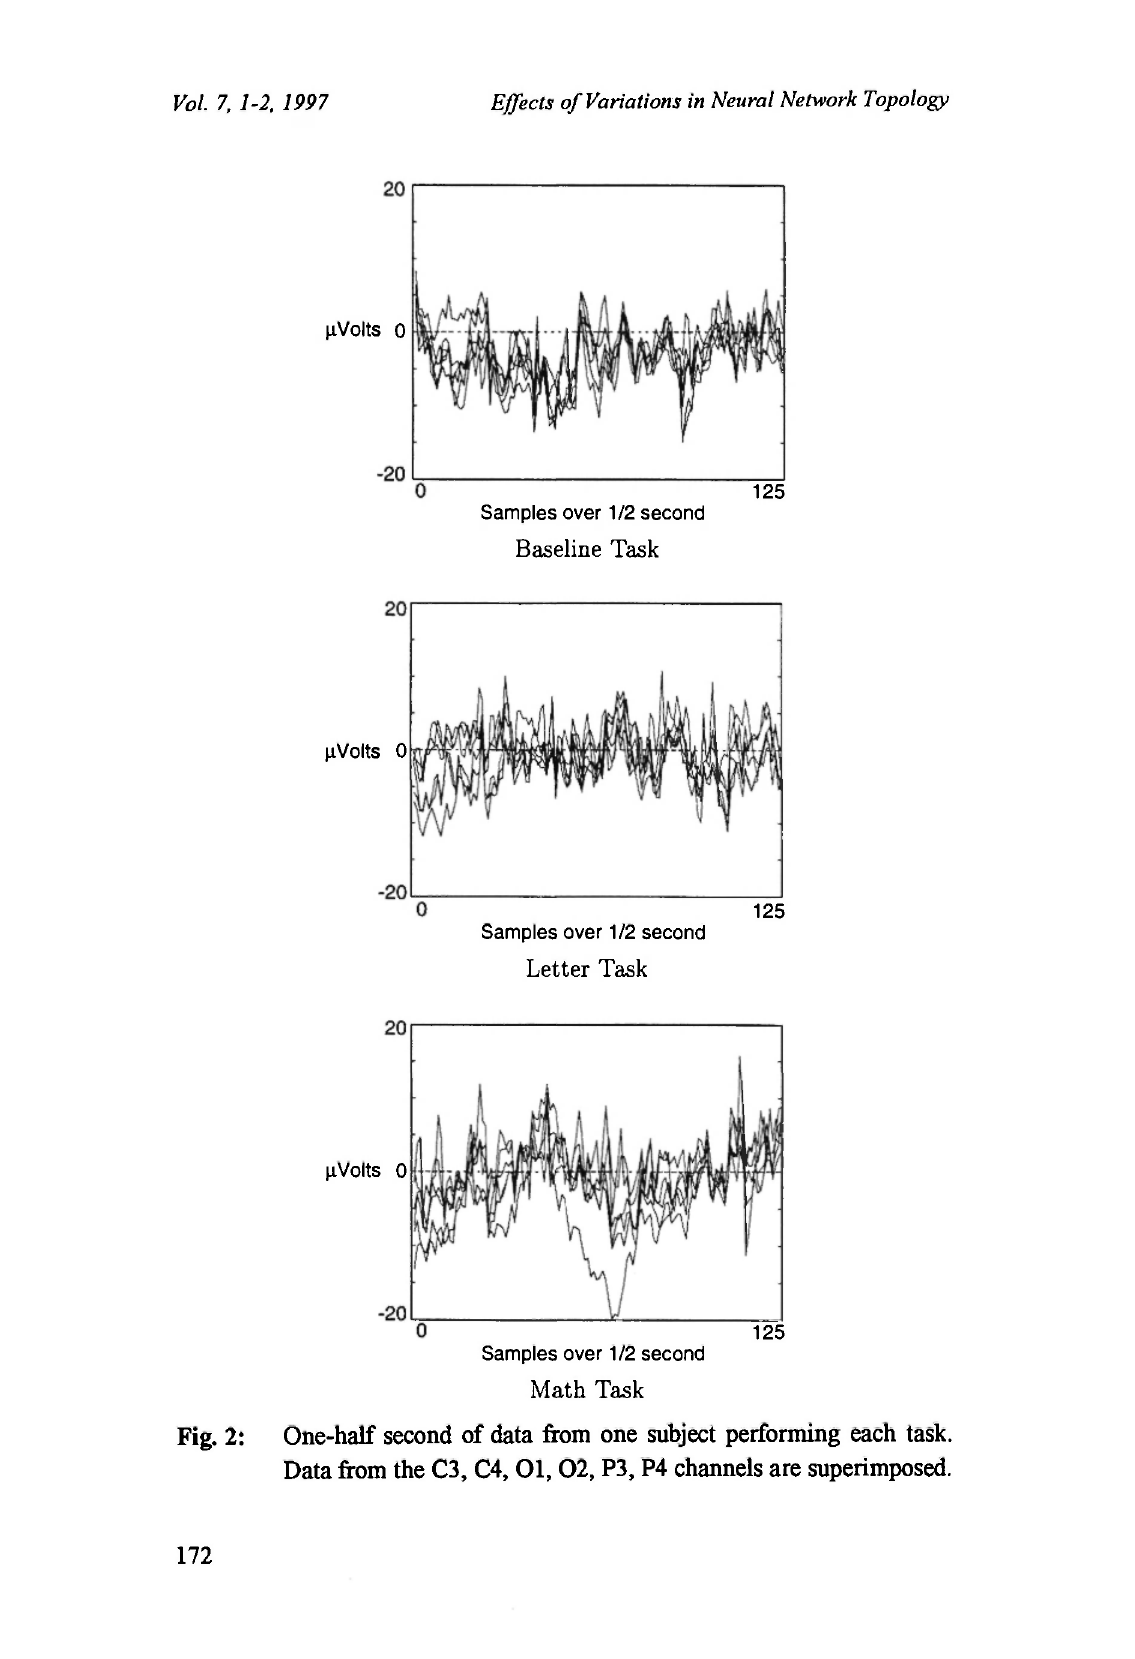
Samples over 1/2 second Math Task One-half second of data from one subject performing each Fig. 2: